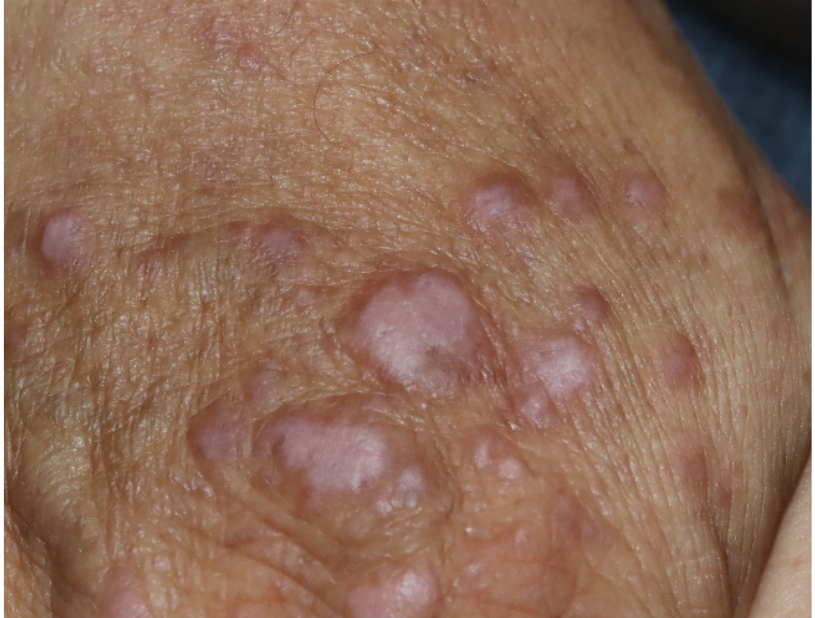
Figure 2. Lichenoid dermatitis. Scattered pruritic, violaceous ‐ to ‐ erythematous, flat ‐ topped scaly papules and plaques on the scalp, face, bilateral dorsal hands, and anterior chest, with a predilection for the sun ‐ exposed area, in a patient with lung cancer receiving atezolizumab.